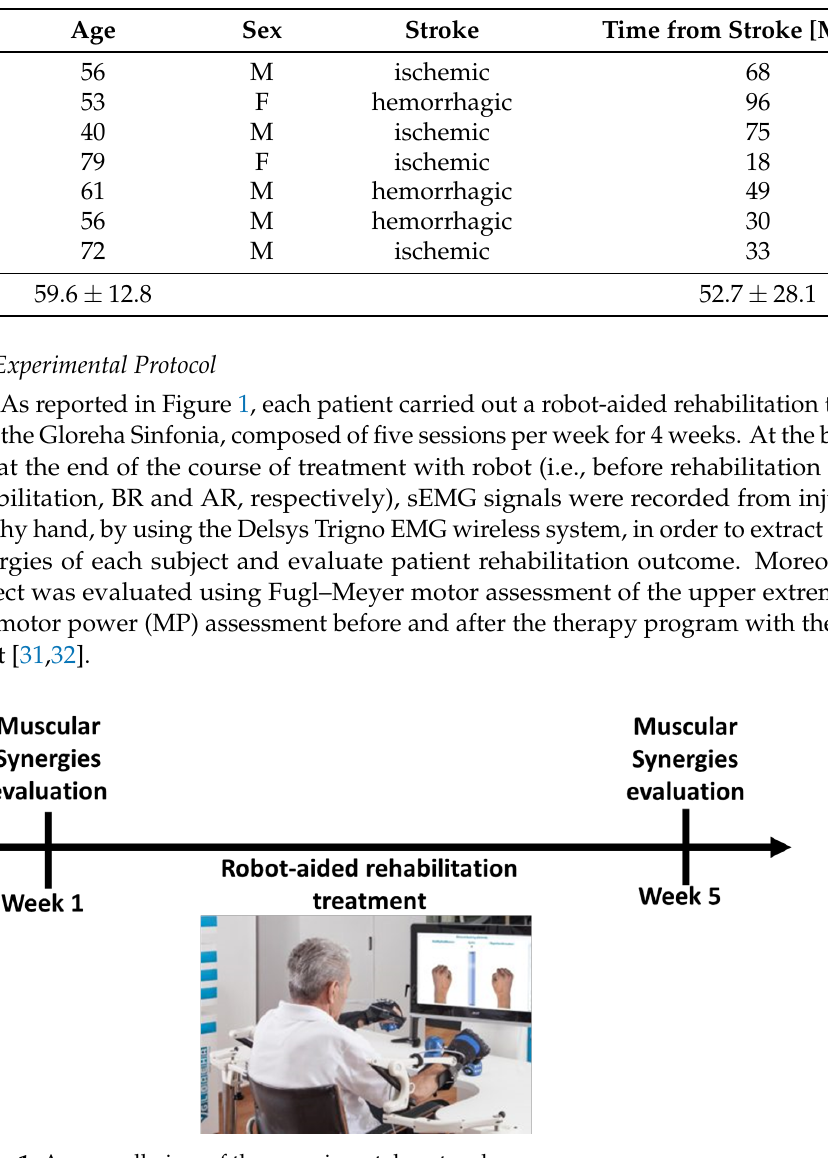
Figure 1. An overall view of the experimental